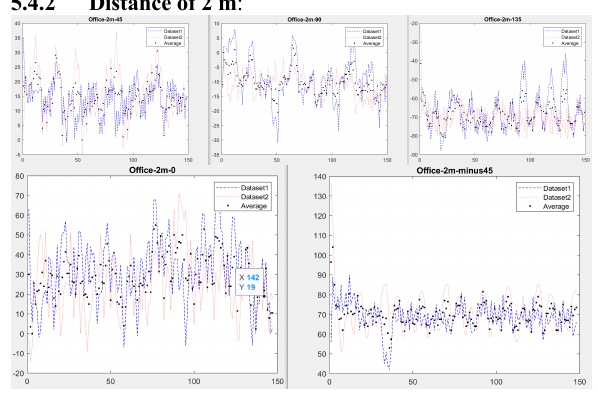
Figure 14 . A further average error plot including more angles at the distance of 2 m.